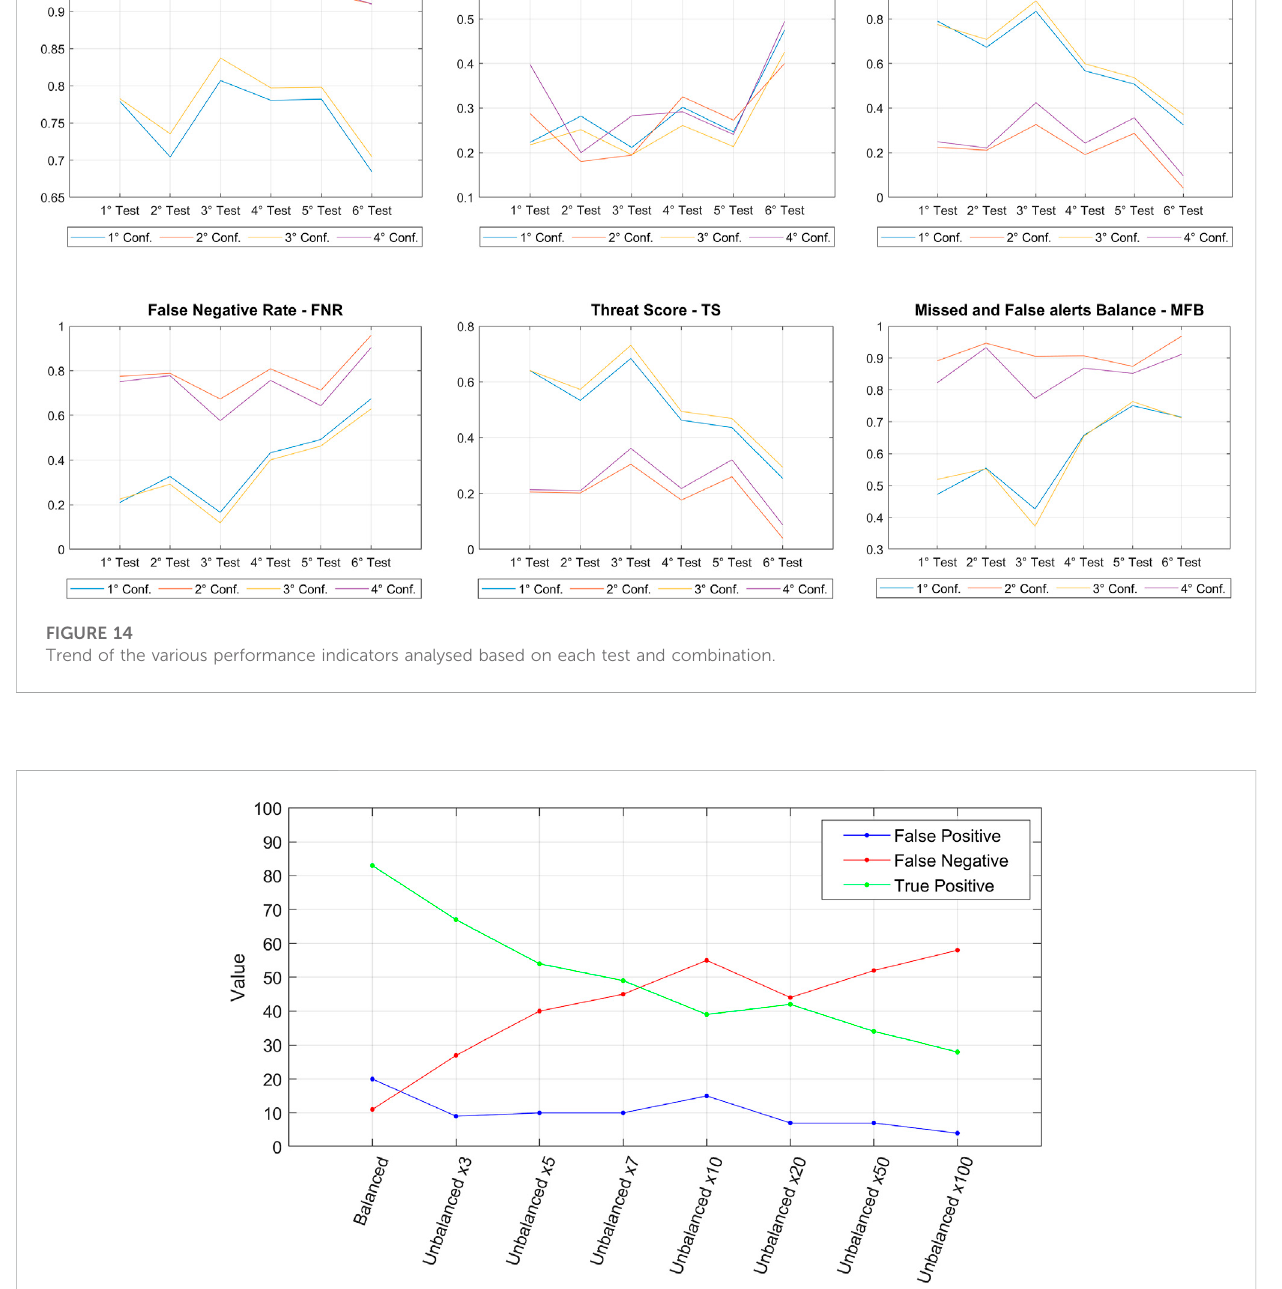
FIGURE 15 Variation of the number of TP, FP and FN varying the degree of imbalance of the